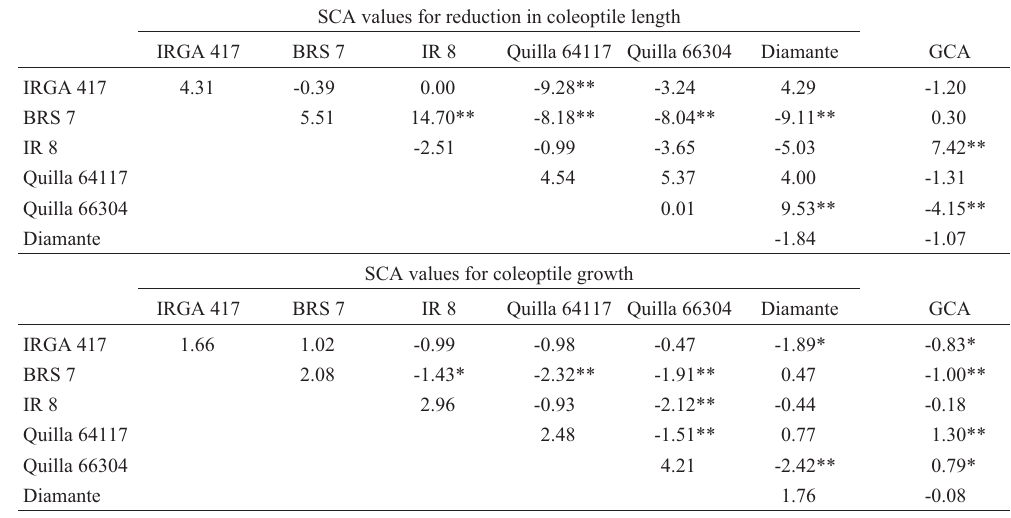
SCA values for reduction in coleoptile